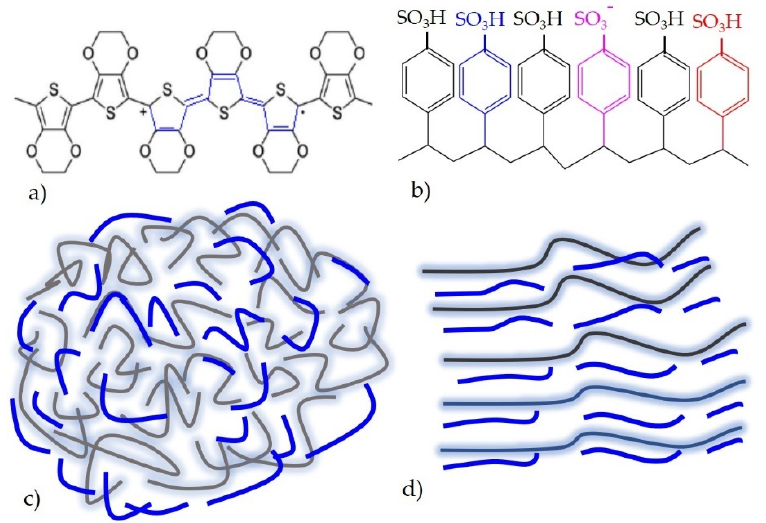
Figure 3. ( a ) Chemical structure of PEDOT; ( b ) chemical structure of PSS; ( c ) when PSS is added to PEDOT; a water dispersion solution is created; ( d ) when PEDOT:PSS is doped with conductive enhancers, a structural re-arrangement is formed, adapted from Ref. [42].